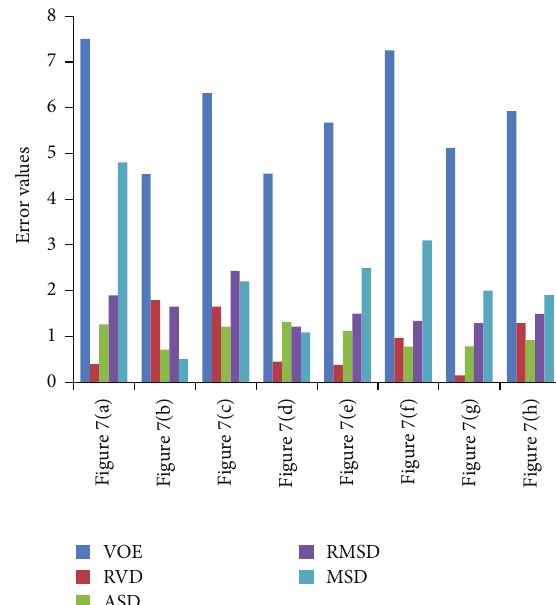
Figure 8: Quantitative evaluation